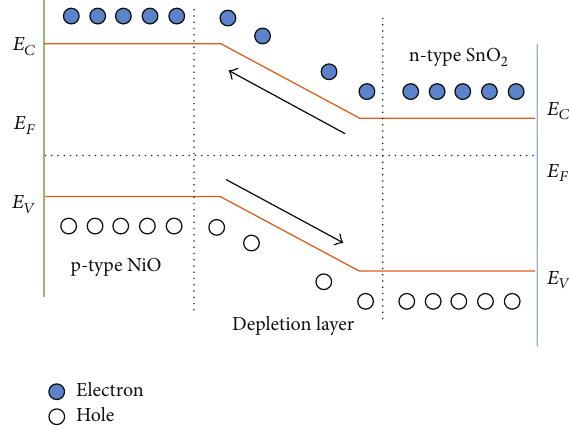
Figure 6: Gas responses of pure SnO 2 and NiO/SnO 2 composites based sensor to 100 𝜇 L/L of H 2 at different working temperature from 150 to 450 ∘ C.